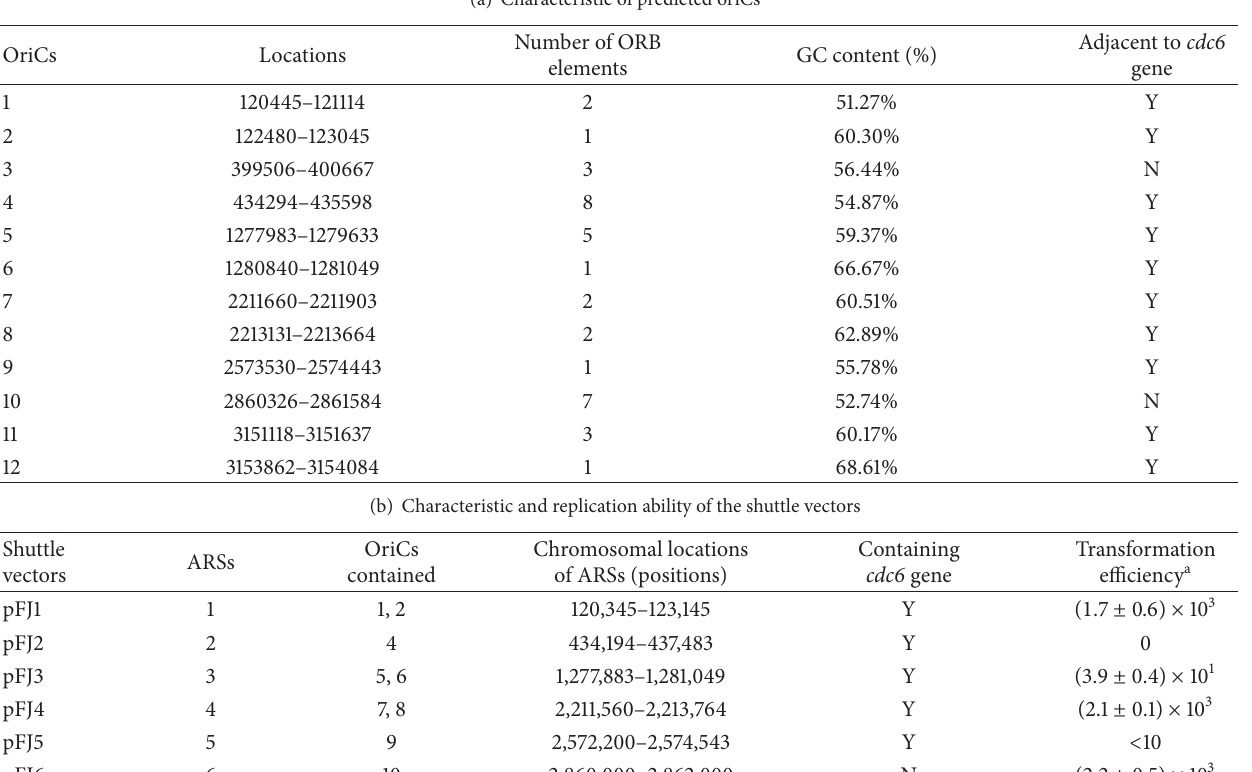
Table 3: Characteristics of predicted oriCs and replication regions used for shuttle vector